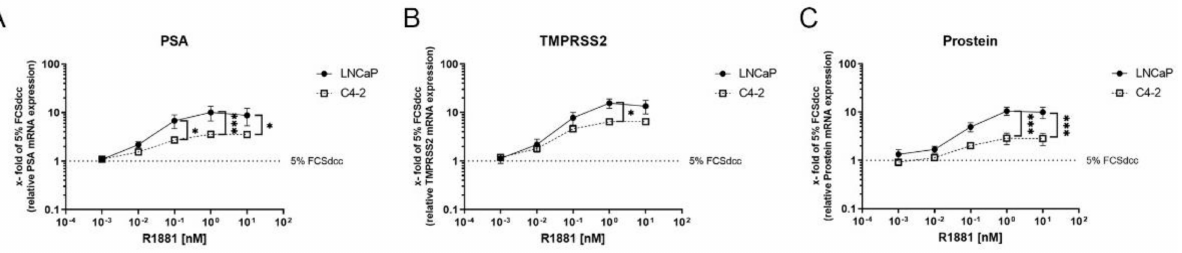
Figure 2. High R1881 concentrations do not inhibit AR-mediated gene transcription: To determine AR- mediated gene transactivation, modulation of mRNA levels of three AR target genes (PSA, TMPRSS2, PROSTEIN) were detected by qPCR and displayed as a mean change of untreated condition (5% FCSdcc, dotted line). ( A – C ) Relative change of the AR target genes PSA ( A ), TMPRSS2 ( B ), and PROSTEIN ( C ) after 16 h of different concentrations of R1881 in LNCaP and C4-2 cells. Values are expressed as x-fold of untreated cells (5% FCSdcc, dotted line) and are displayed as mean ± s.e.m. ( n = 3). All differences highlighted by asterisks were statistically significant (* p ≤ 0.05, *** p ≤